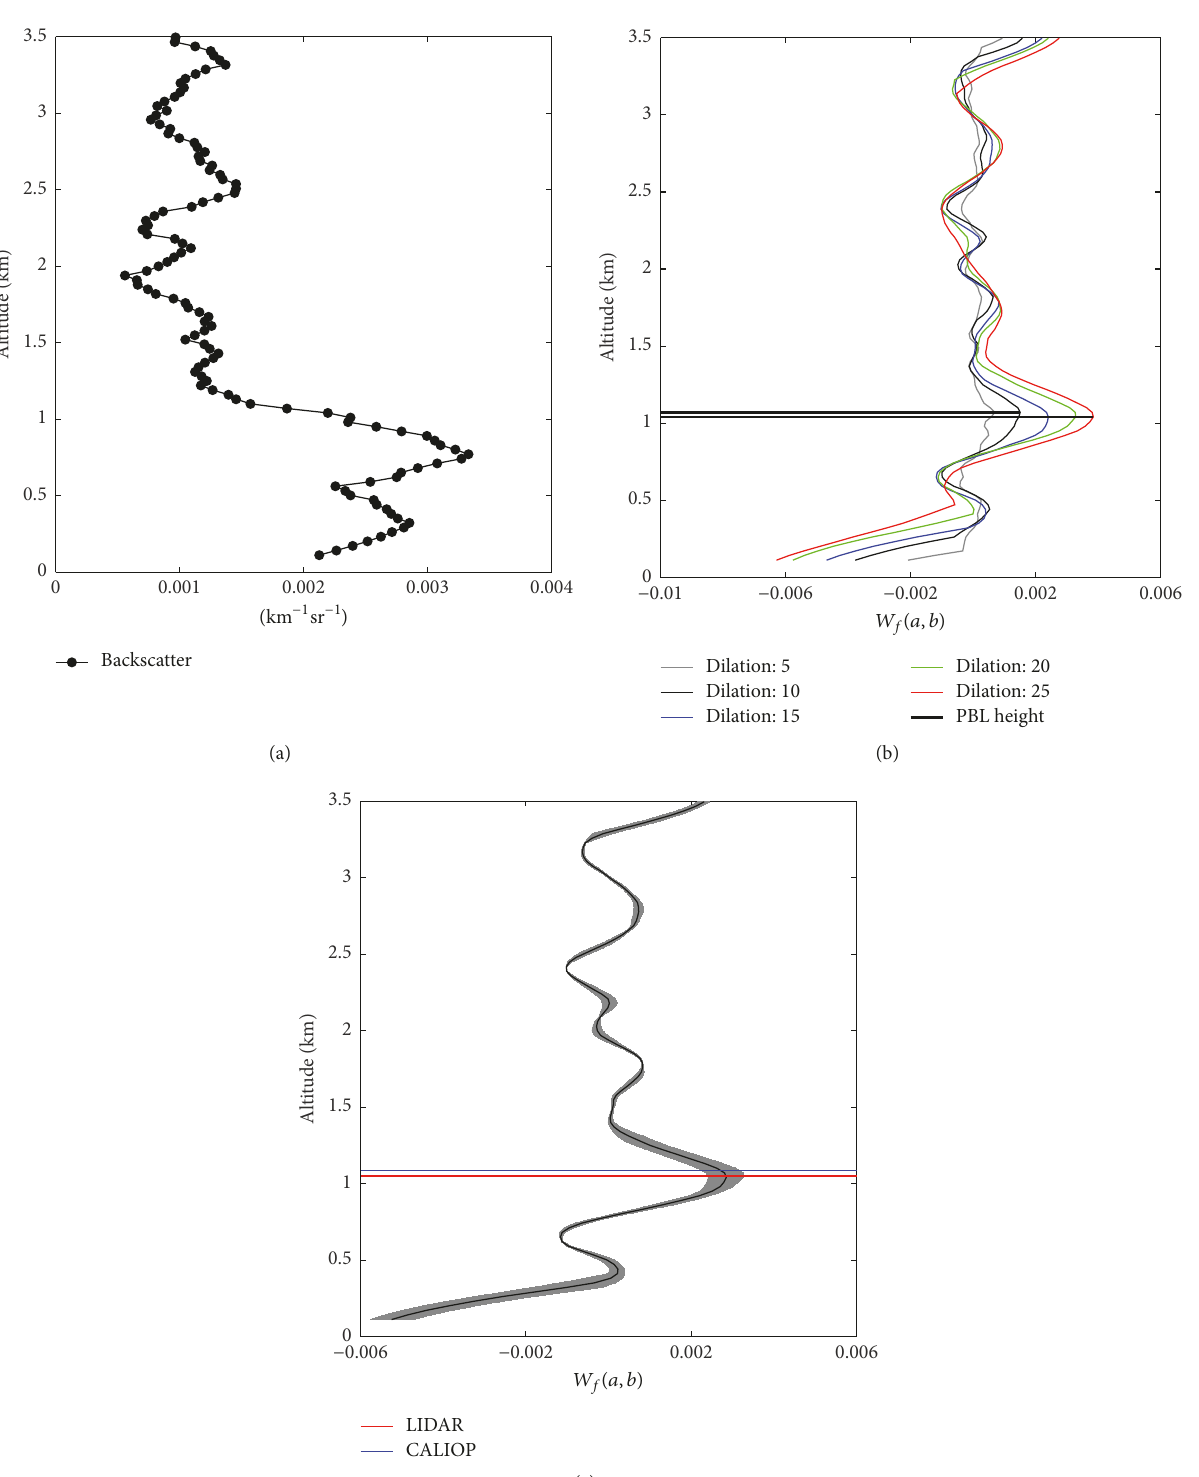
Figure 2: Example of the wavelet covariance transform. The CALIOP profile was acquired at 12:51 UTC (daytime) on September 4, 2013. (a) The total attenuated backscatter at 532 nm acquired by CALIOP, (b) result of the covariance transform for different wavelet dilations applied to the profile in (a), and (c) result of top heights of PBL derived from CALIOP and ground-based Lidar,